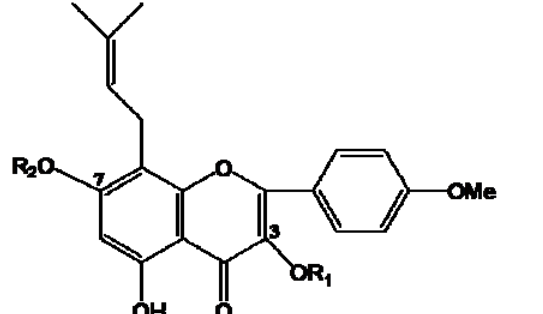
Figure 1. Structures of icariin, baohuoside I, epimedin A and epimedin C in Herba Epimedii in this